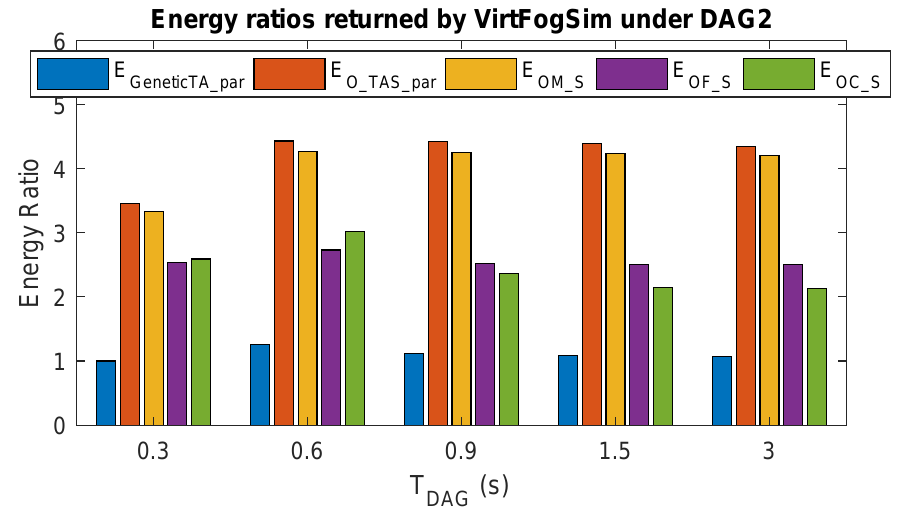
Figure 11. Energy ratios returned by VirtFogSim under DAG2 for T DAG = 0.3 s, 0.6 s, 0.9 s, 1.2 s, and 1.5 s. All the reported ratio values are normalized with respect to the corresponding total energies consumed by ES_S_par